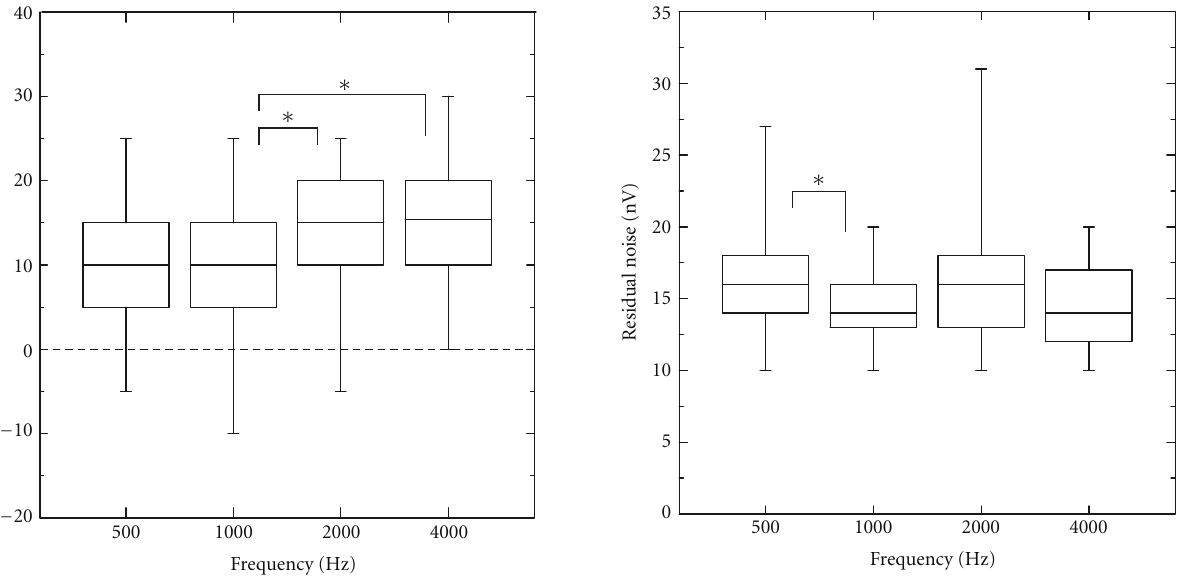
Figure 3: Di ff erences between multiple ASSR thresholds and be- havioural pure-tone thresholds for 32 subjects at 500, 1000, 2000, and 4000Hz. Outer limits of each box represent the 25th and 75th percentiles, with the median shown as the line within the box. Whiskers indicate the 5th and 95th percentiles. (Bonferroni’s post hoc tests: ∗ P < 0 . 05).